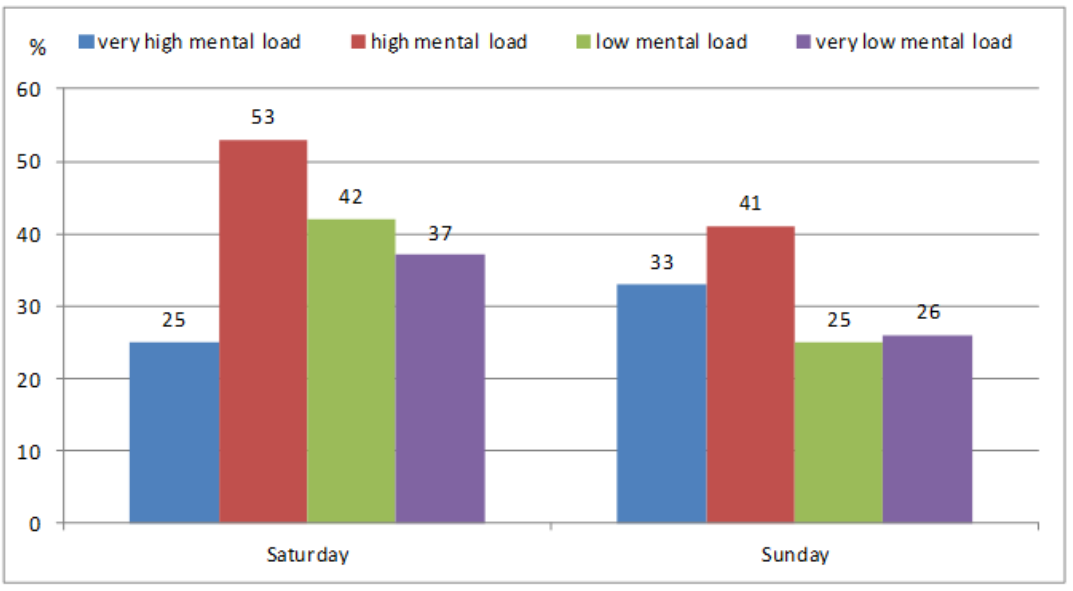
Figure 2. PA volume (steps/day) in participants with various levels of mental load on two school days and two weekend days.